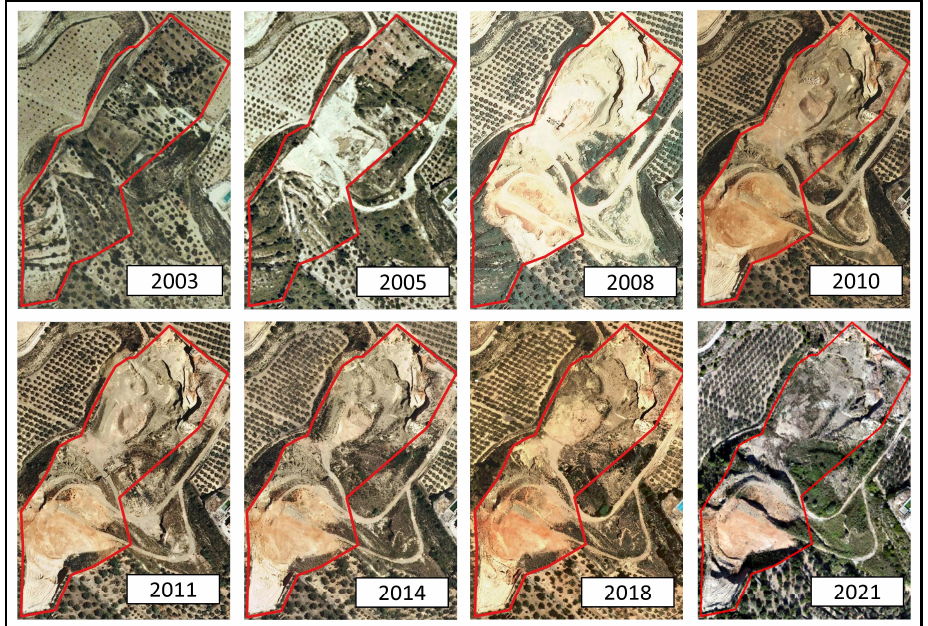
Figure 2. Multitemporal aerial orthophotos of the period 2000–2021 [23].